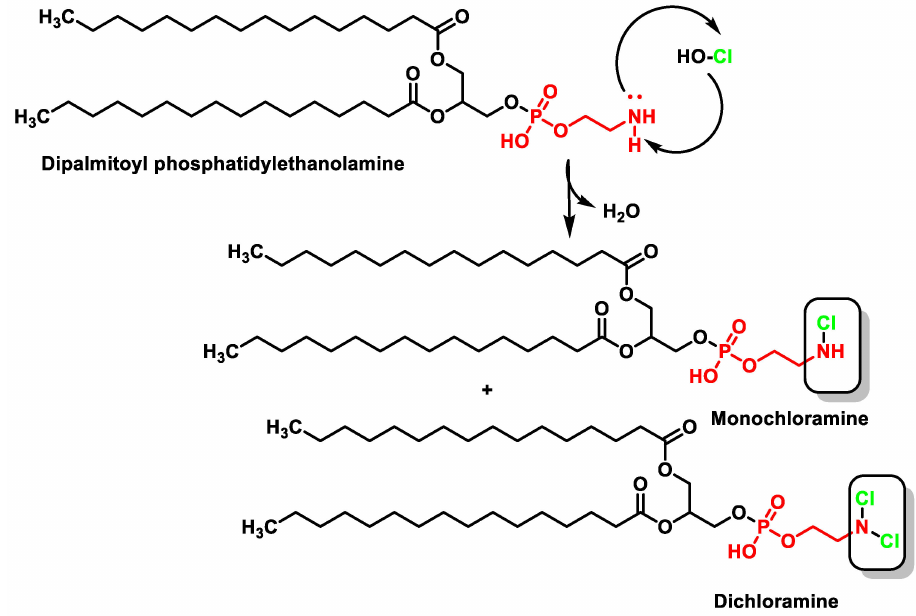
Figure 14. Formation of monochloramine and dichloramine from the oxidation of dipalmitoyl phosphatidylethanolamine by hypochlorous acid.